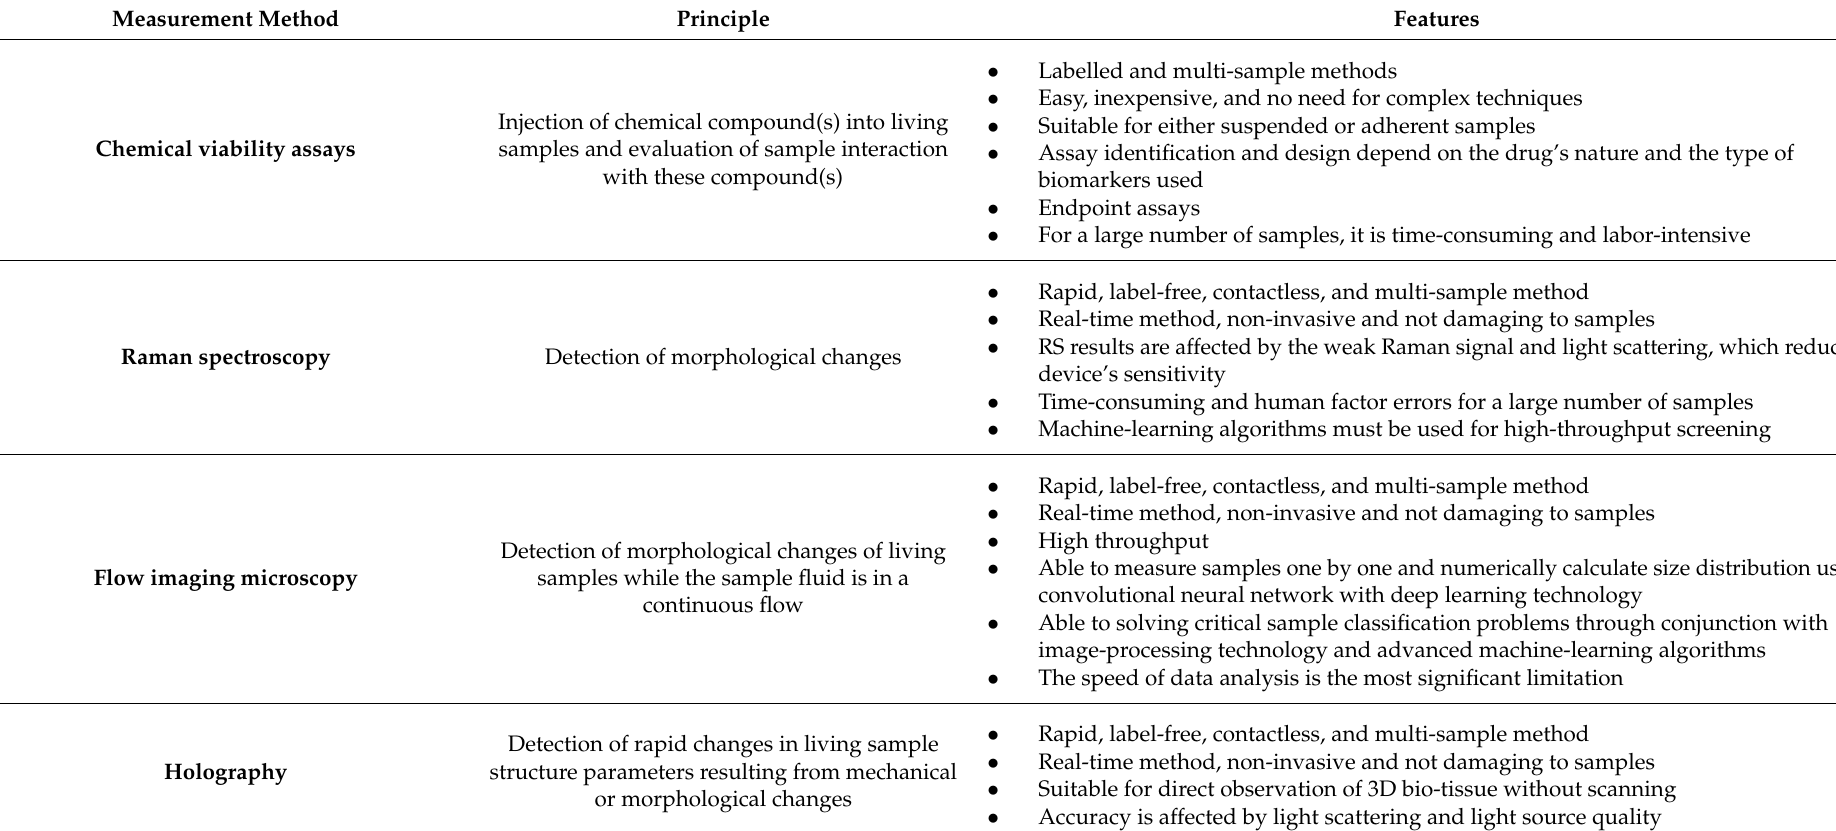
Table 3. Principles and features of